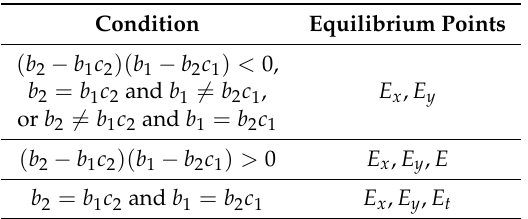
Table 2. The equilibrium points of system